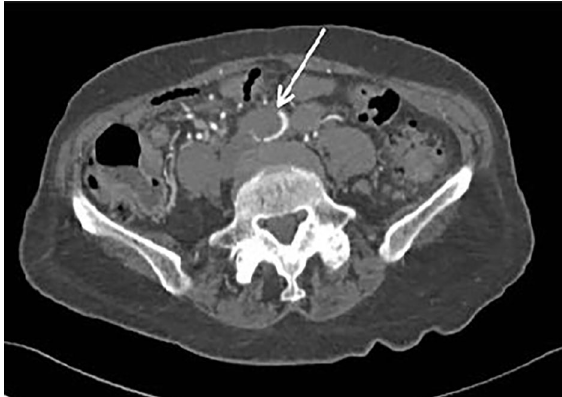
Image 2. Computed tomography angiography axial image demonstrating occlusive thrombus (white arrow) in the distal abdominal aorta just proximal to the aortic